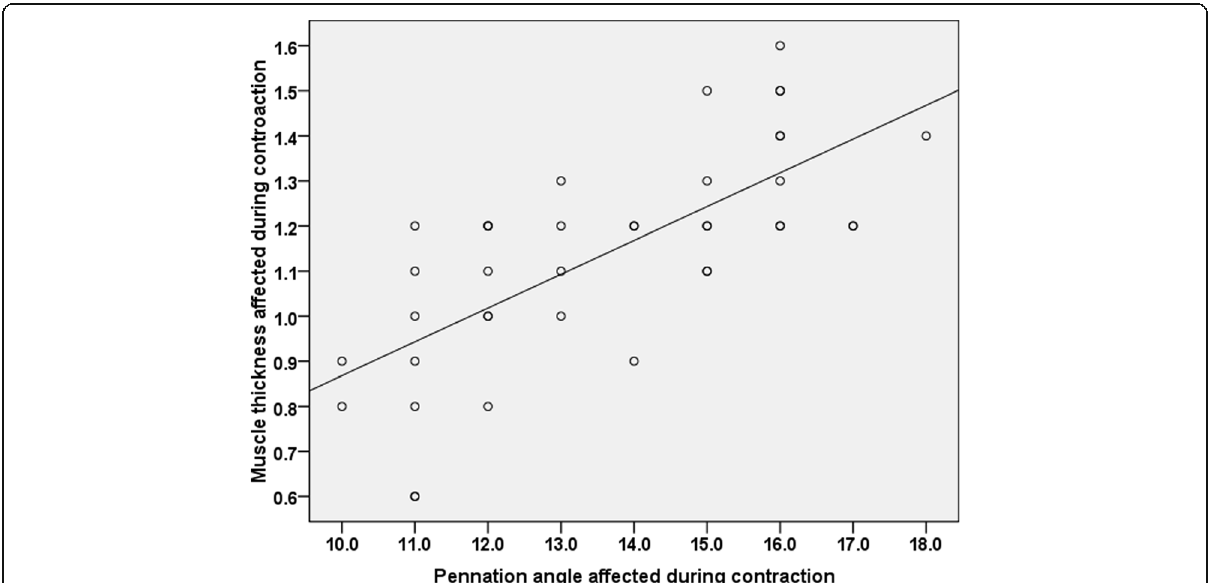
Fig. 7 Correlation between muscle thickness in the affected side during contraction and pennation angle in the affected side during contraction ( r = 0.717; P = 0.001)